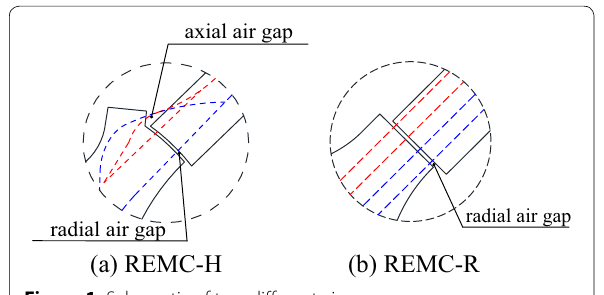
Figure 1 Schematic of two different air